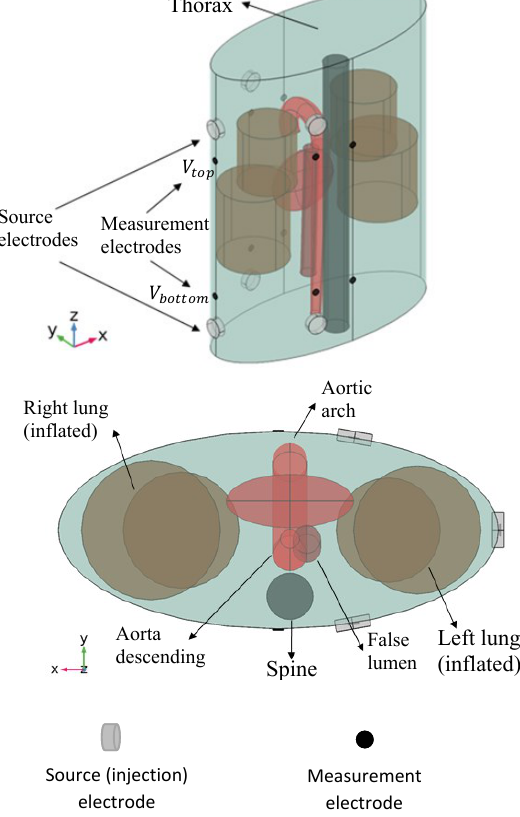
Fig. 6: Simulation model setup. a) 3D view – b) 2D bottom